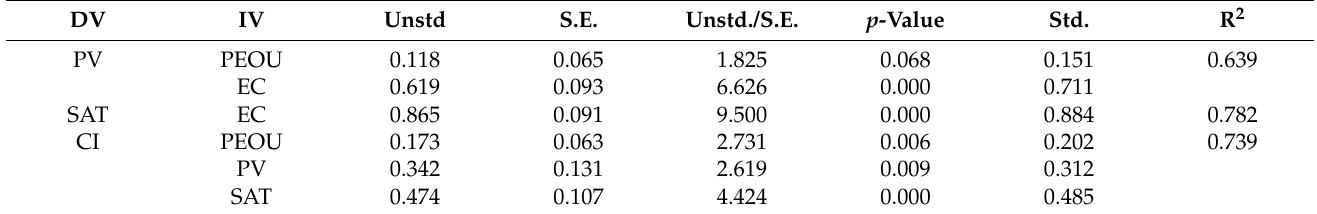
Table 7. Regression coefficient of research model III (TAM-ECM Integrated Model).